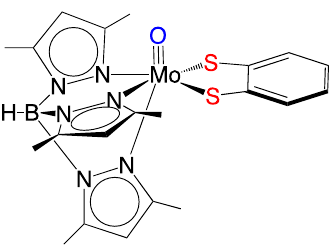
Figure 6. The Tp*Mo V O(bdt) model. Note that the apical oxo ligand can be changed to a terminal sulfido or nitrosyl to probe the electronic structure of the Mo–dithiolene unit. The bdt ligand can also be conveniently interchanged with a large variety of other